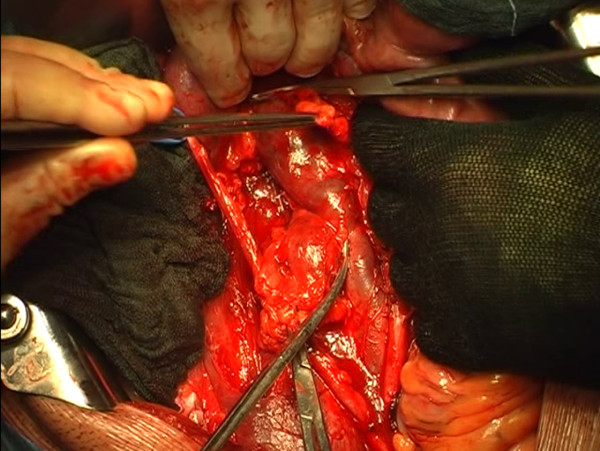
The caval lymph-node dissection begins. The right side of the horseshoe kidney was dislodged from the posterior planes of the abdominal cavity, flipped superomedially en bloc with its vascular structures to expose the mass.